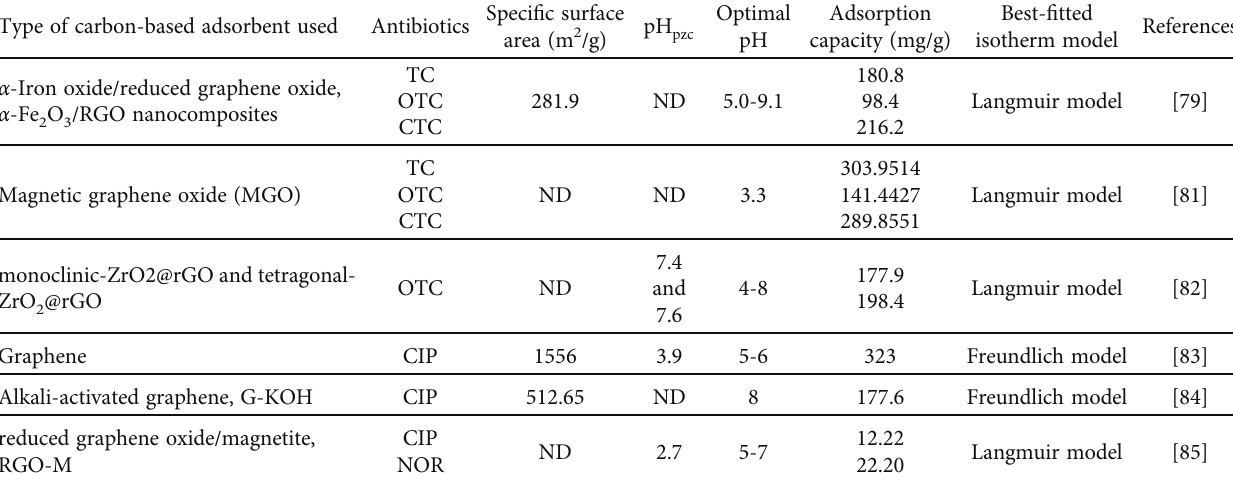
Table 4: Antibiotics adsorption by graphene and their oxides. The adsorptive characteristics of the adsorbents are summarised. ND: not